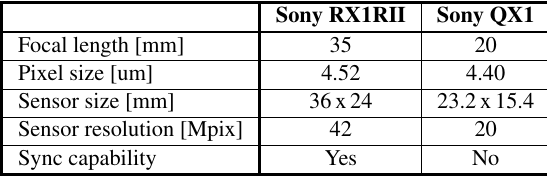
Table 1: Parameters of two cameras used.